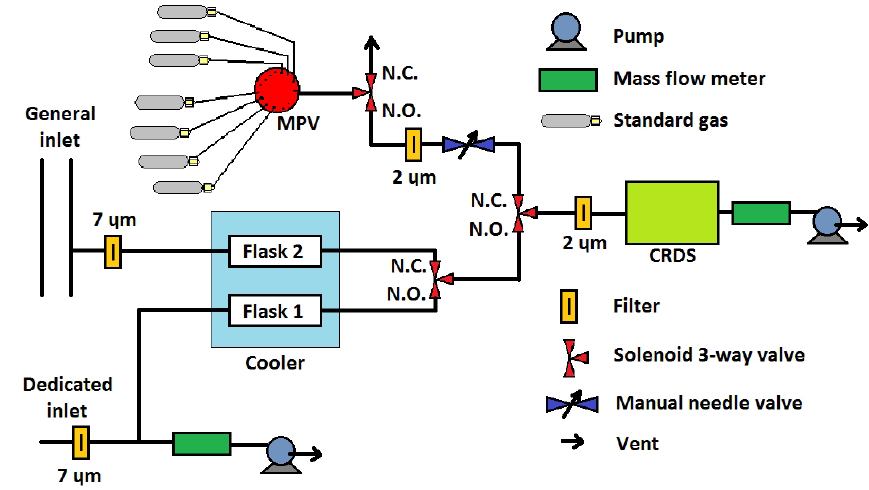
Figure 12. Ambient air/gas standard plumbing configuration operational since 28 November